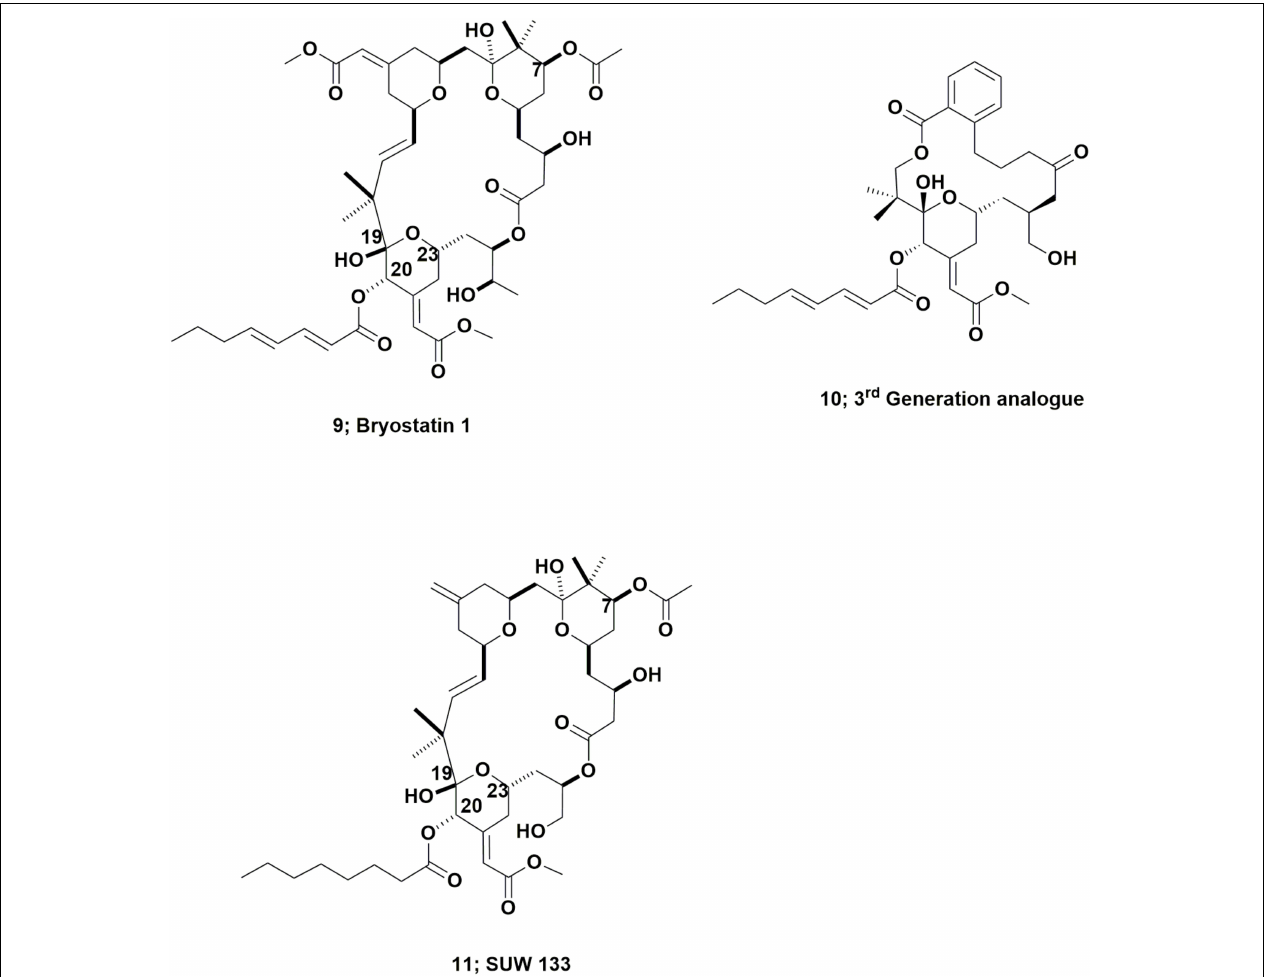
FIGURE 3 | Bryostatin 1 and